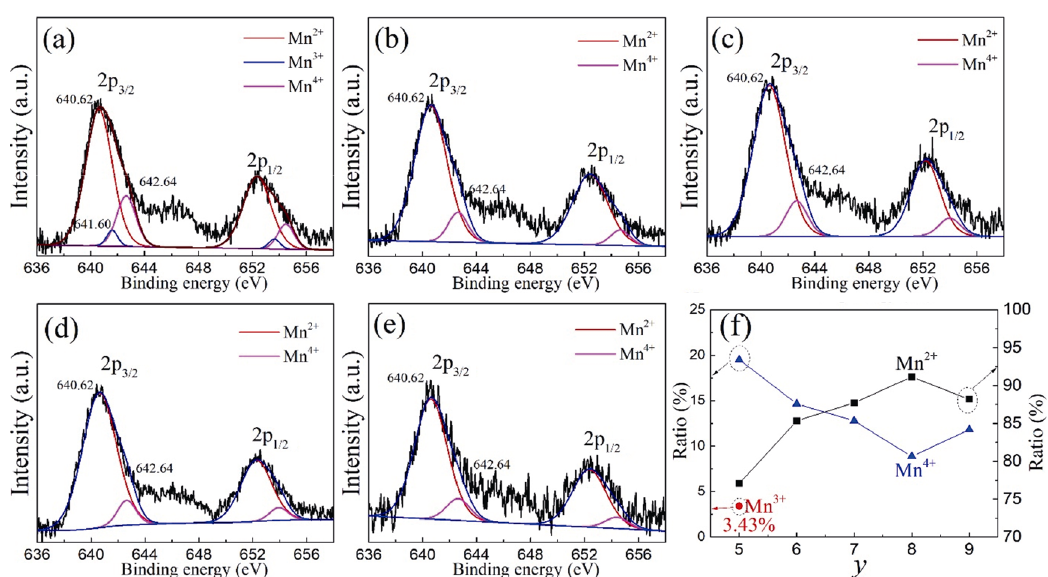
Fig. 3 XPS of Mn 2p for KNNT–0.055BZ + 0.03Zr + y Mn ceramics: (a) y = 5, (b) y = 6, (c) y = 7, (d) y = 8, and (e) y = 9. (f) The ratios under the peaks located at ~640.62 (Mn 2+ ), ~641.60 (Mn 3+ ), and ~642.62 eV (Mn 4+ ) of Mn 2p of KNNT–0.055BZ + 0.03Zr + y Mn